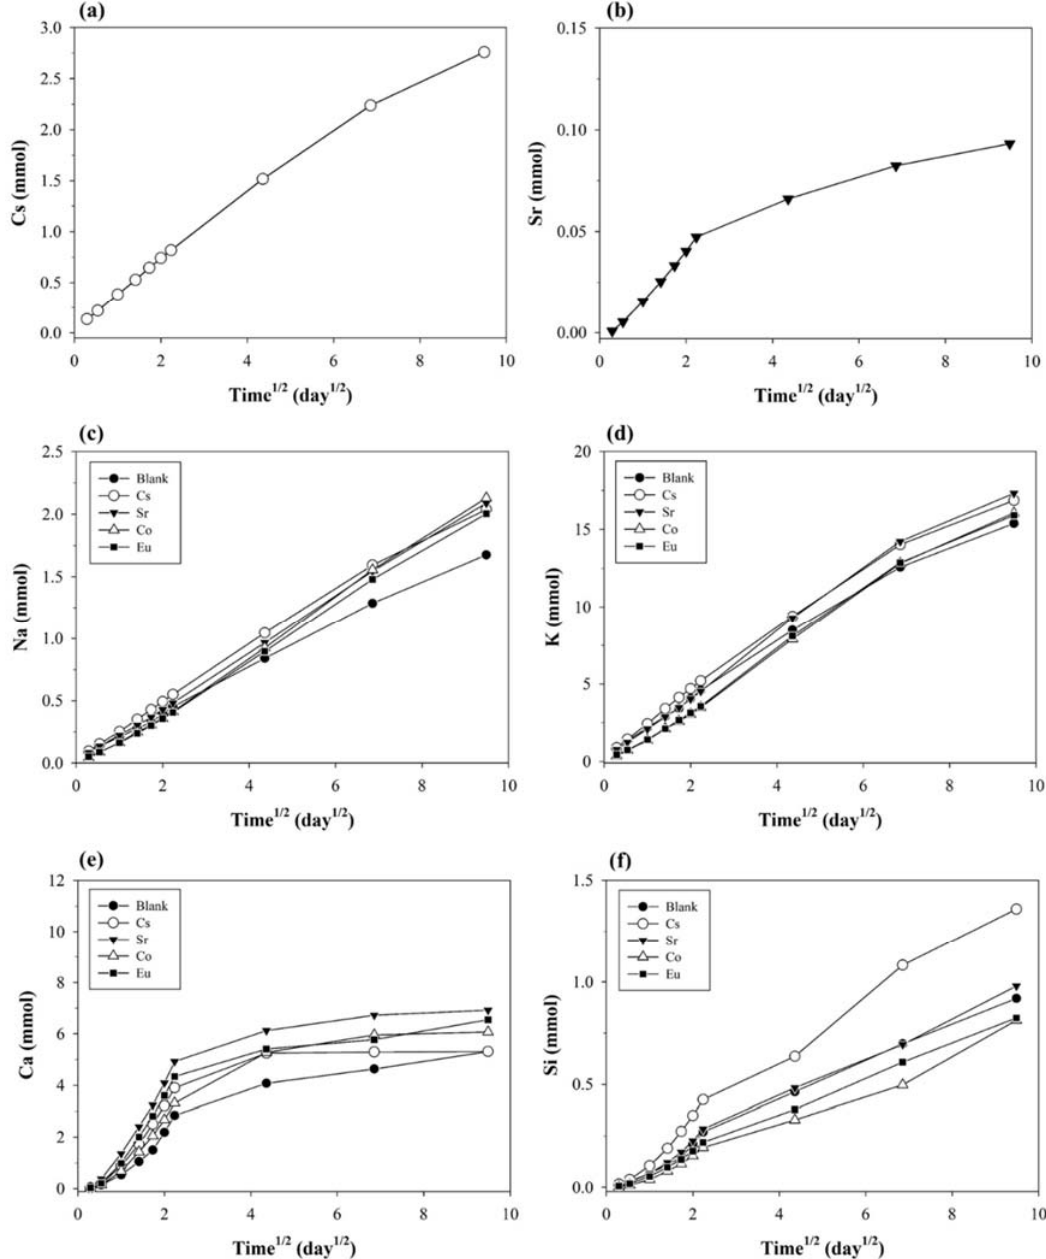
Figure 9. Cumulative concentrations of nuclides: ( a ) Cs and ( b ) Sr and major elements: ( c ) Na, ( d ) K, ( e ) Ca, and ( f ) Si leached from the solidified cement specimens up to 90 days of testing.